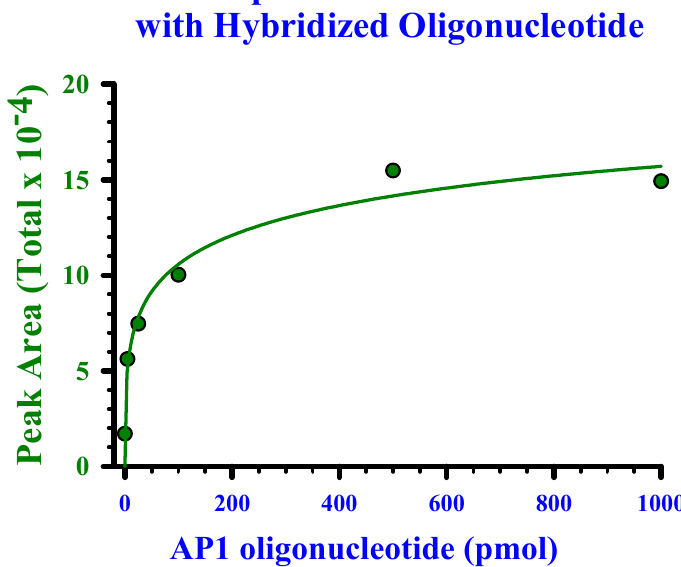
Figure 2. Saturation curve of increasing quantity of AP1 oligonucleotide applied to the epoxide surface of a PS-20 chip prior to incubation with 42 pmol of recombinant c-Jun. Saturation was estimated at approximately 250 pmol of hybridized oligonucleotide. The curve was fit to the data points using the function: y = ax b /(c b +x b ), with an r 2 =